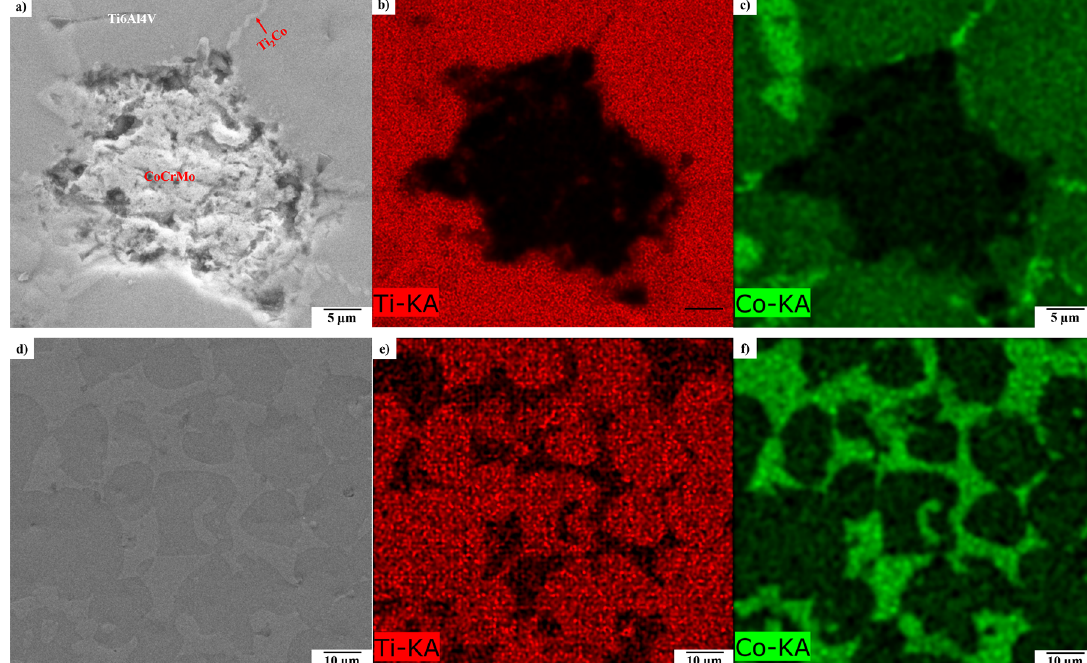
Figure 5. EDS elemental mapping of the composite Ti6Al4V/CoCrMo at different temperatures: a), b) and c) 1050 °C and d), e) and f) 1130